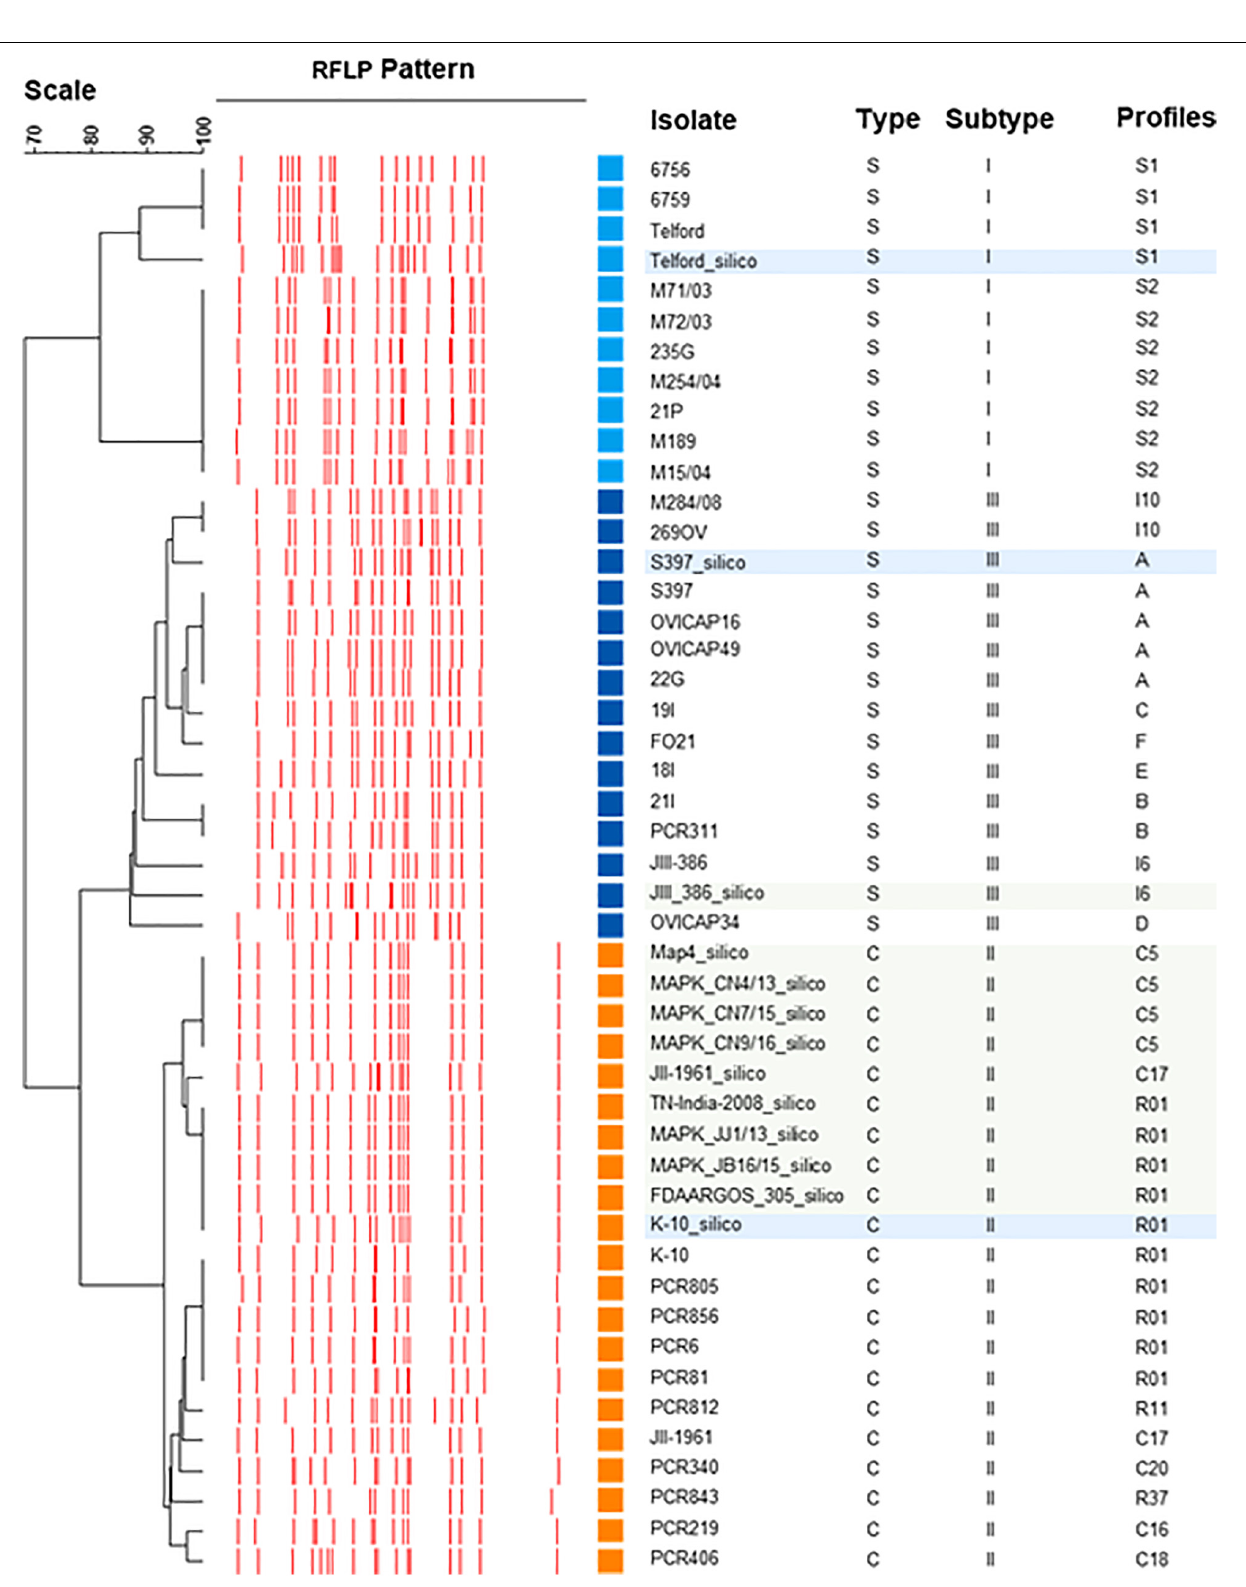
Frontiers in Microbiology |